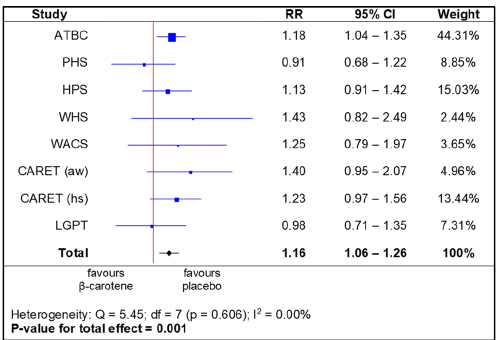
Figure 3. Meta-analysis in total—lung cancer incidence depending on beta-carotene supplementa- tion (legend: ATBC—Alpha-Tocopherol, Beta-Carotene Cancer Prevention Study; PHS—Physicians’ Health Study; HPS—Heart Protection Study; WHS—Women’s Health Study; WACS—Women’s workers; CARET (hs)—Carotene and Retinol Efficacy Trial, heavy smokers; LGPT—Linxian General Population Trial).